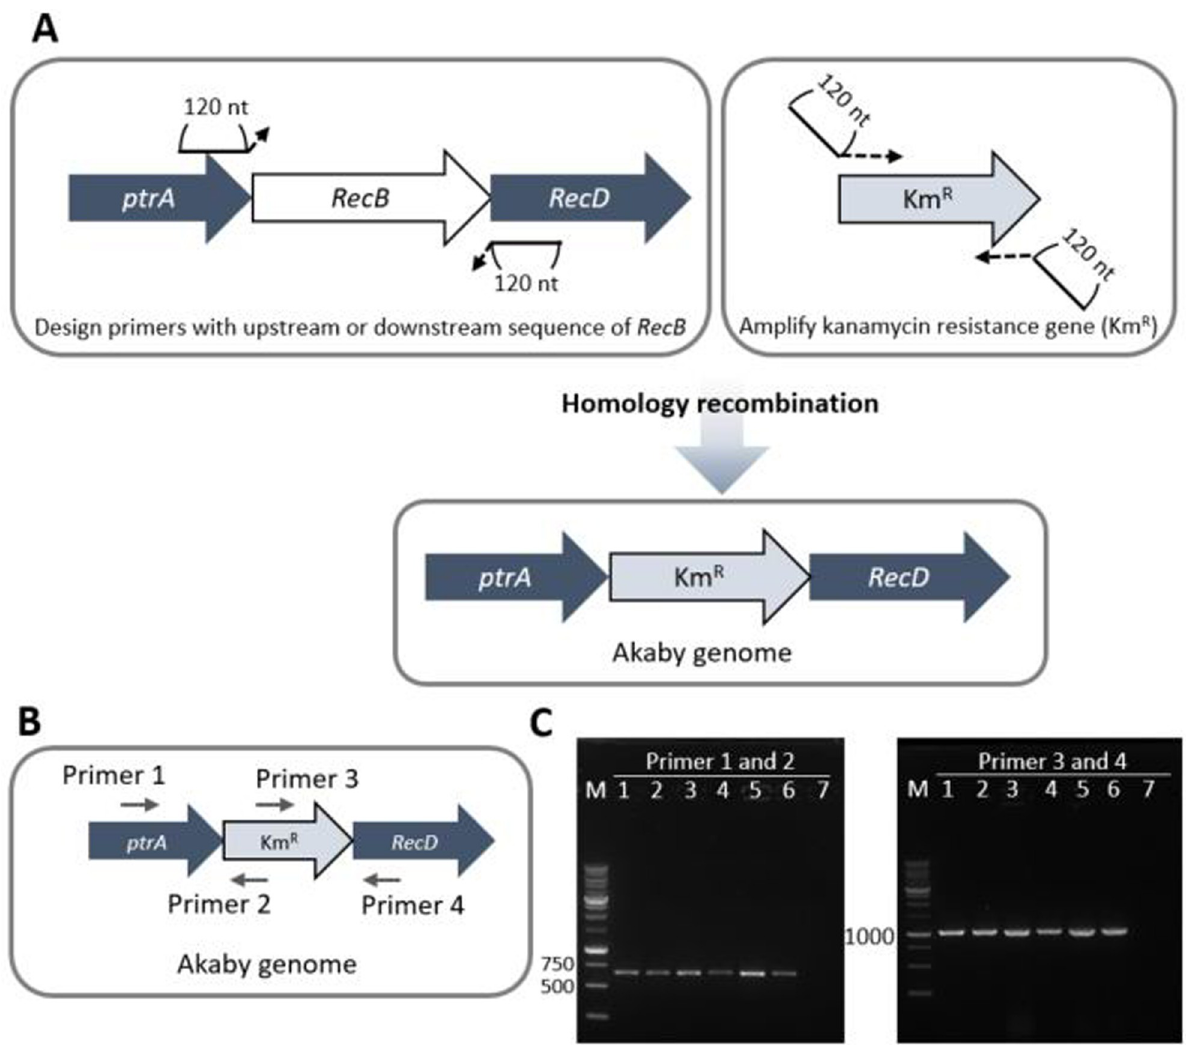
Fig 1. Overview of the RecB knockout experiment. (A) The primer designs for Kanamycin resistant gene (Km R ) PCR. The primers contains 120nt upstream or downstream sequences of RecB in E . coli genome. (B)The primer designs for colony PCR. Primer 1 and 4 have complement sequences outside of RecB in E . coli genome. Primer 2 and 3 have complement sequences within Km R . (C) Agarose gel images of colony PCR. 1% agarose gel was run at 125 V for 45min, stained with SYBR safe DNA Gel stain. Expected product size: 661 bp (left gel) and 1035 bp (right gel). Lane M: 1 kb DNA ladder (Goldbio, D010-500) lane 1~6: RecB replaced E . coli NEB5 α colonies, 7: wild type E . coli NEB5 α colony.